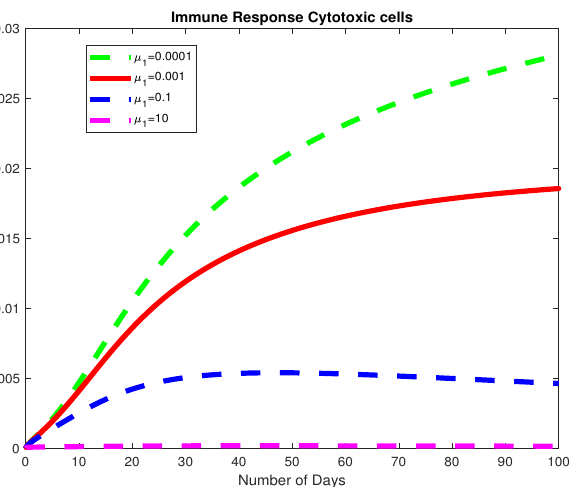
Figure 16. The dynamics of the Immune response cytotoxic cells ( R ) for varying values of µ 1 .